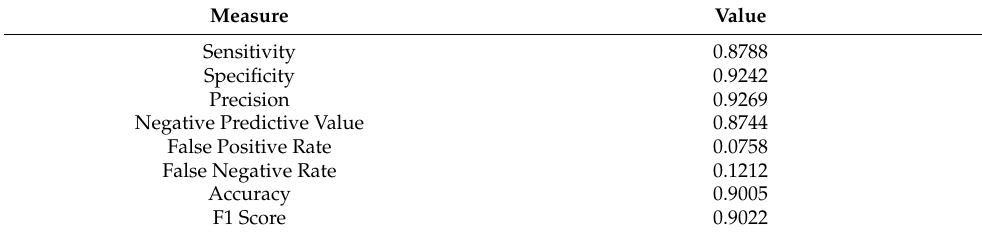
Table 12. Maxvoting Ensemble Confusion Matrix Measure Values.